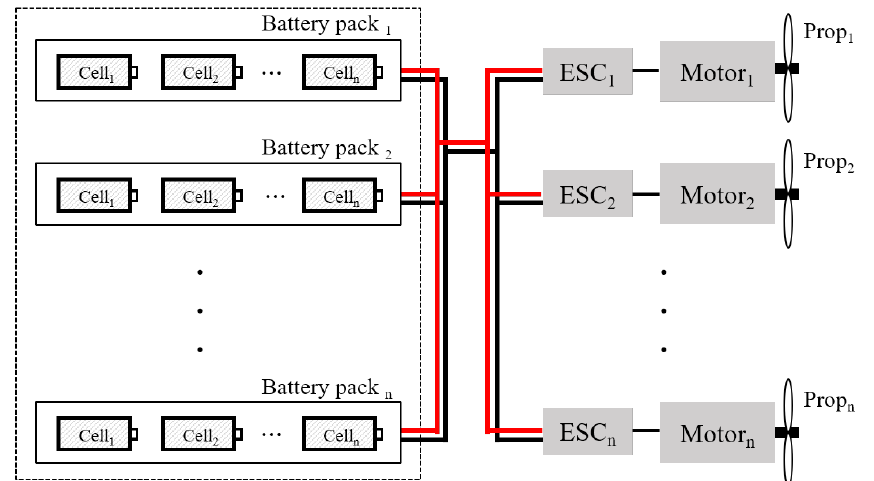
Figure 1. Typical configuration of the electric propulsion system of multicopter unmanned aerial vehicles